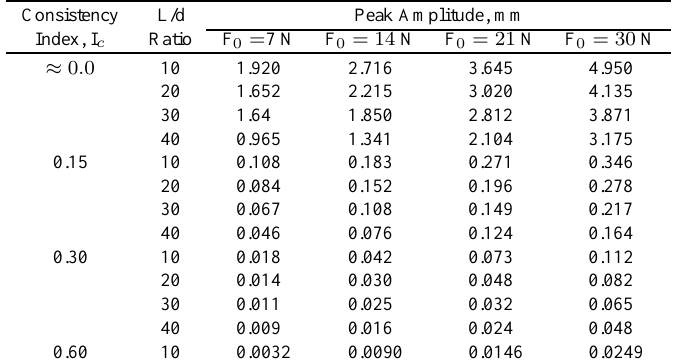
Table 3 Measured peak amplitude of soil-pile system